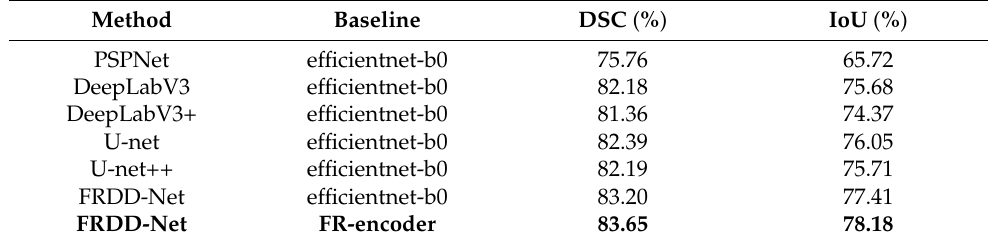
Table 1. Overall quantitative comparison results of the carotid plaques in terms of dice similarity coefficients (DSCs) and intersection over union